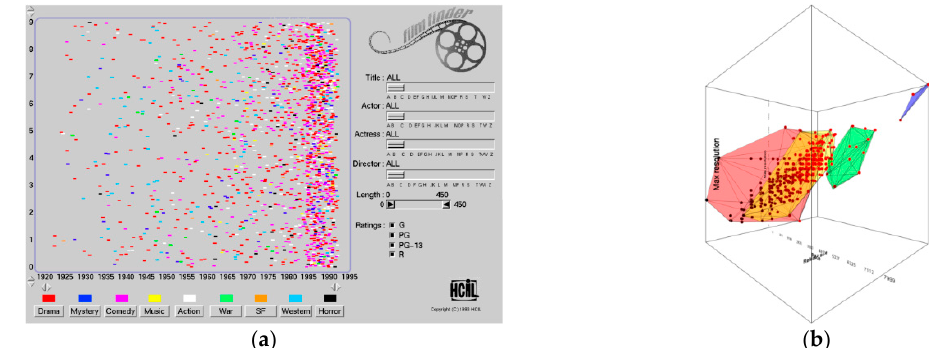
Figure 46. Scatter-plot visualizations: ( a ) 2D scatter plot [123]; and ( b ) 3D scatter plot [122].